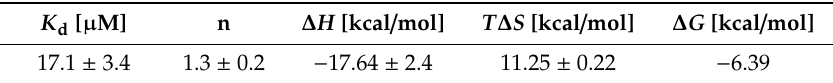
Table 1. Thermodynamic parameters for calcium binding to C-terminally truncated testican-2 (T2 ∆ C). ∆ H , ∆ S and ∆ G correspond to changes in enthalpy, entropy and Gibbs free energy, respectively, and T denotes